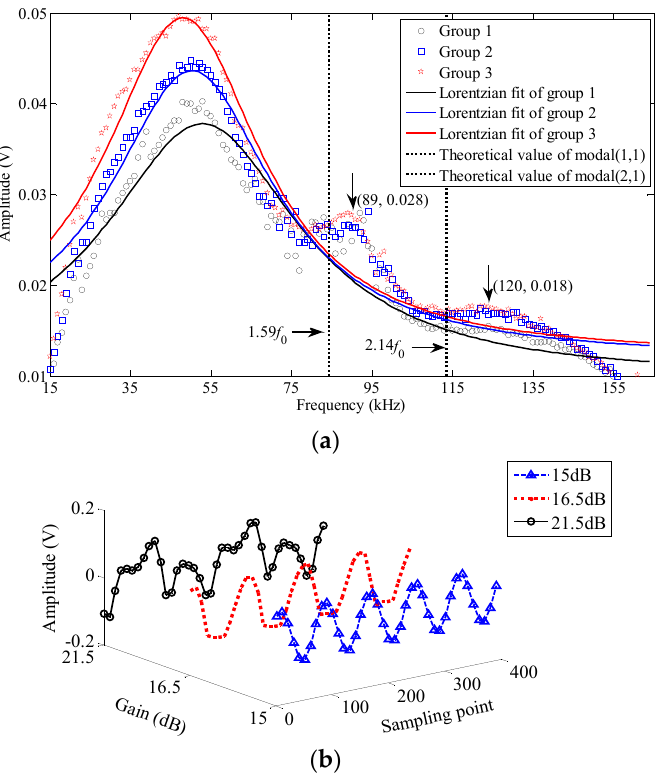
Figure 6. ( a ) Measured resonance spectrum and ( b ) nonlinear distortion due to increasing optical power at 0 °C.